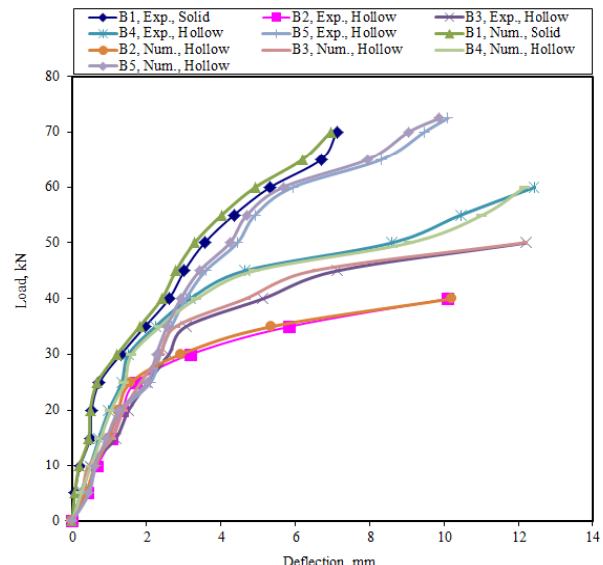
Figure 17. Experimental and numerical load versus mid-span deflection curves of all the RC beams.